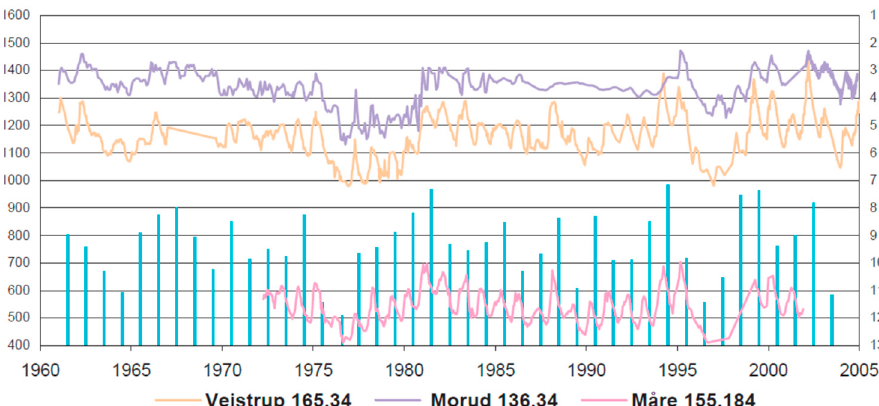
Figure 10. Illustration of development of groundwater level in surroundings of Odense. The figure shows annual precipitation (mm on left-hand axis, blue columns) compared with groundwater depth in the three national monitoring wells (in m below ground level on right-hand axis) (Vejstrup 165.34, Morud 136.34 and Måre 155.84) [35]. Data from Geological Survey of Denmark and Greenland and Danish Meteorological Institute, processed by the local water utility (VCS Denmark).